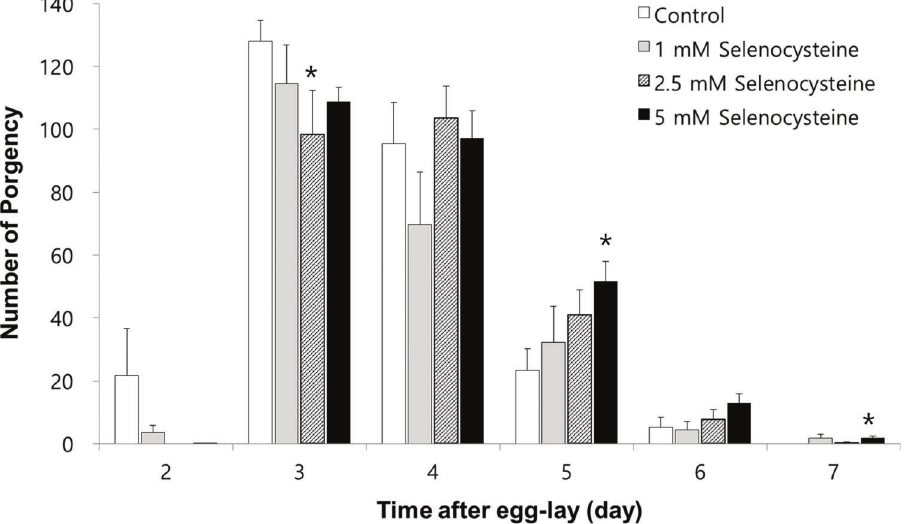
Figure 4 - Effects of selenocysteine on reproduction. The number of progeny produced was monitored every day during a gravid period. Data show the mean number of progeny produced by 10 individual worms on each day. Asterisks indicate p -values less than 0.05 compared with the untreated